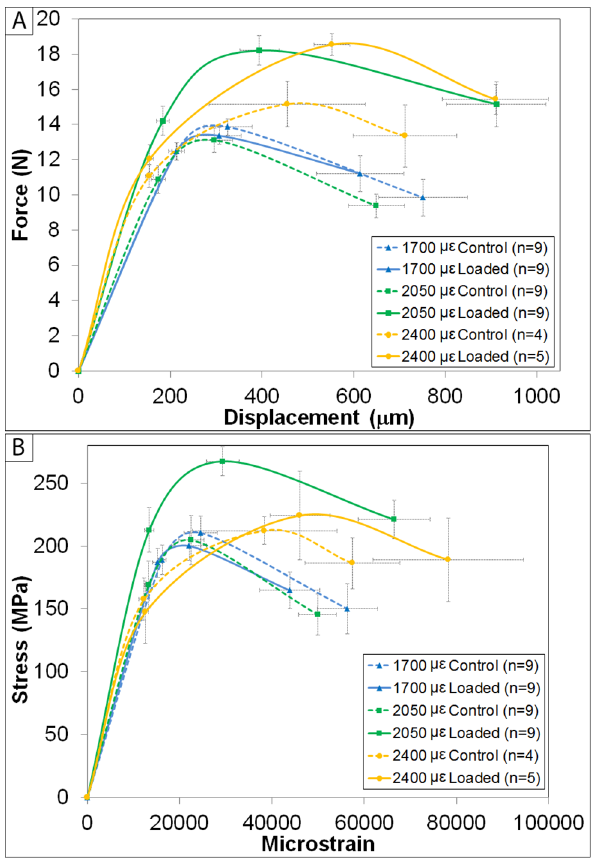
Fig 5. Schematic representations of mechanical testing curves. A) Representative structural-level force/ displacement curves. B) Estimated tissue-level mechanical curves. At 1700 με , there was no mechanical effect noted. Those limbs loaded to 2050 με experienced significant increases in structural- and tissue-level strength and energy dissipation. The 2400 με group also experienced gains. However, when animals that experienced a woven bone response were removed from the analysis, the gains were more modest (especially at the tissue-level) and most failed to reach significance versus the contralateral control limb given the loss in power. For all data points, error bars represent the standard error of the mean